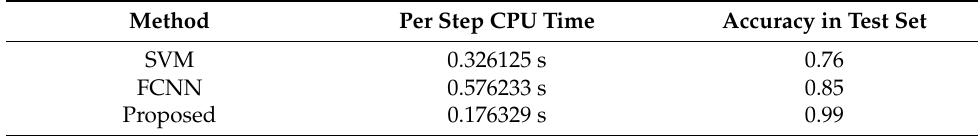
Figure 9. Accuracy of different models on the collected dataset. The running time of the proposed techniques and the final results on the test set are shown in Table 5. The results show that the proposed model balanced accuracy and efficiency. Table 5. Comparison of different methods on the collected dataset. Method